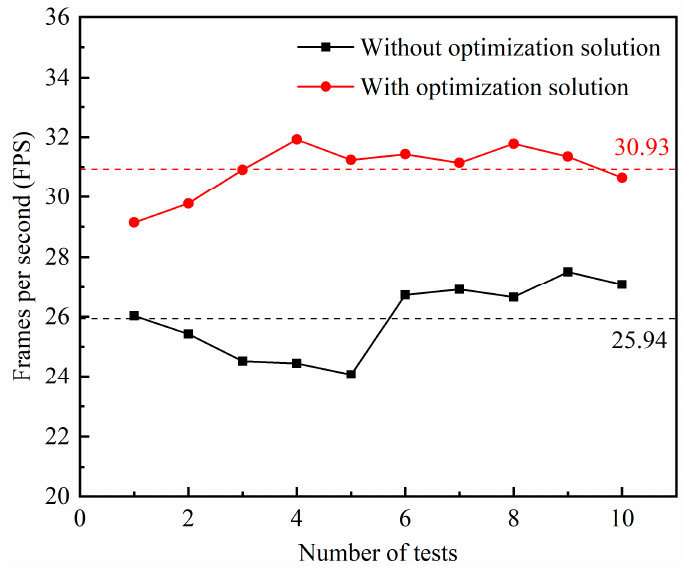
Figure 4. Frames per second (FPS) without and with the optimization solution.